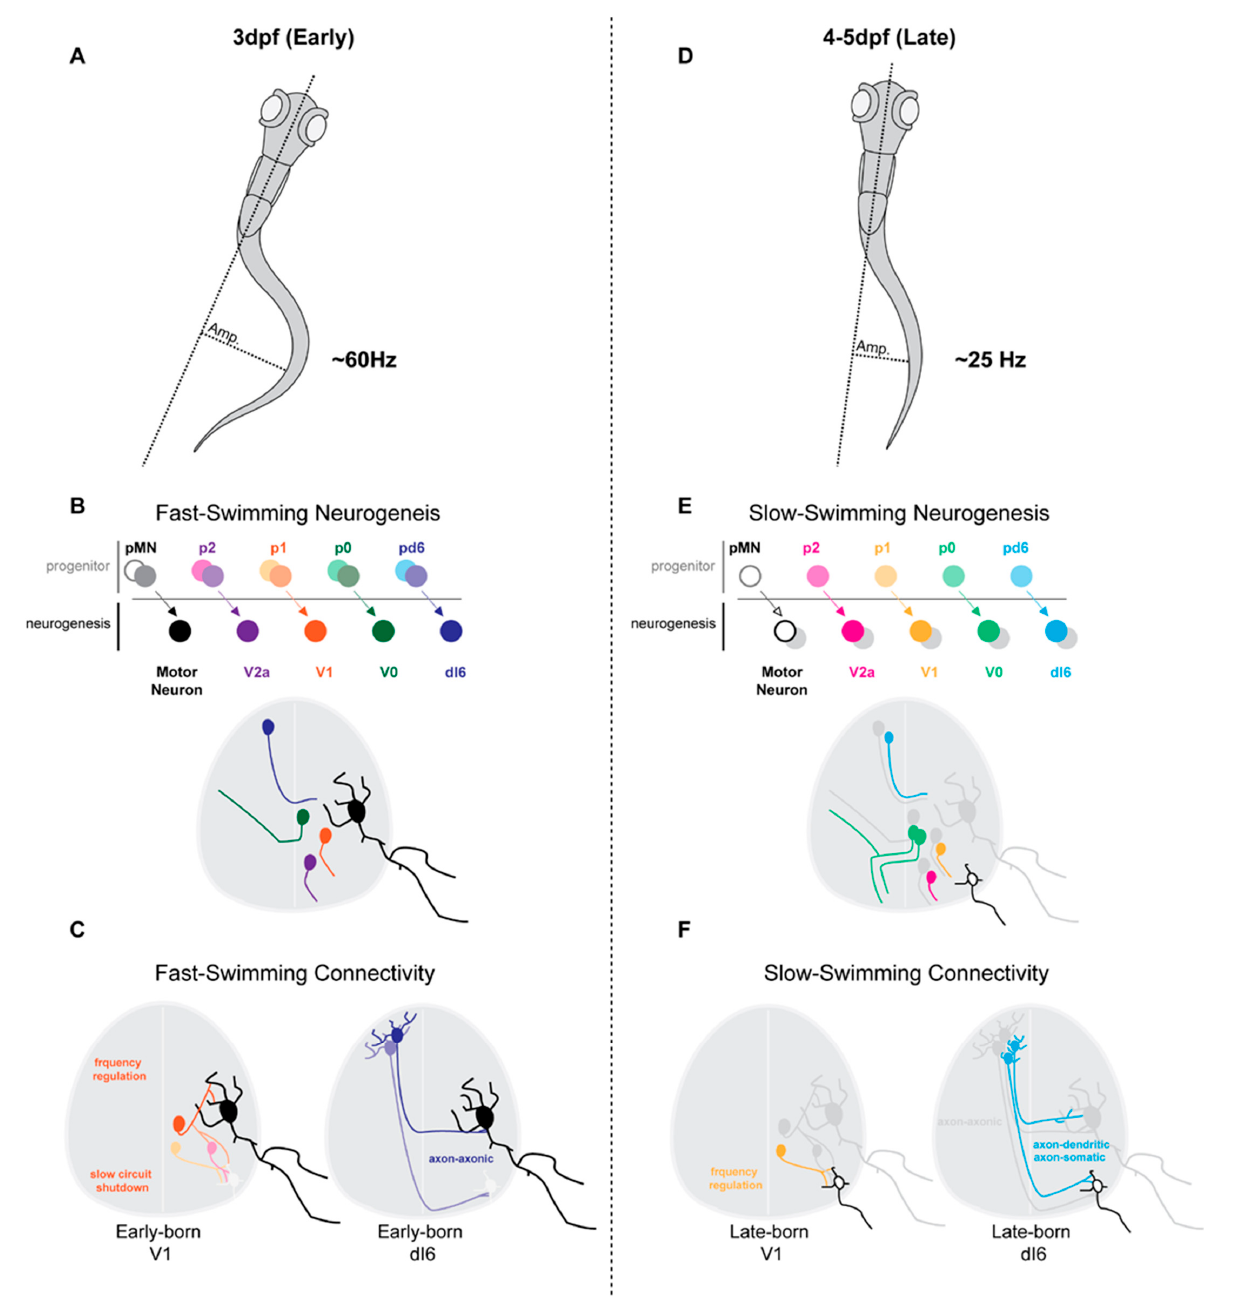
Figure 2. Sequential waves of neurogenesis separate zebrafish spinal cord neurons along neurogenesis time- and speed-matched axes. Large amplitude (Amp) and high frequency swimming emerge early, at 3 days post feralization (dpf), in the zebrafish larvae ( A ). Small amplitude (Amp) and low frequency swimming emerge later, at 4–5 days post feralization (dpf), in the zebrafish larvae ( B ) [48,49]. Early maturation of swimming behaviours is underscored by sequential waves of neurogenesis ( C ), early-born and fast swimming recruitment; ( D ), late-born and slow swimming recruitment; motor neurons (MNs), [49]; V0, [48,49,55]; V2a INs, [52]; V1 INs, [53]; dI6 INs, [62]. Neurogenesis time- and speed-matched spinal IN subclasses display distinct circuit connectivities. Early-born V1 INs regulate MN burst termination of primary MNs during fast-swimming as well as slow-swimming circuit shutdown of slow speed V2a INs and secondary MNs [54]. Early-born dI6 INs form axon-axonic synaptic connectivities with MNs and are recruited during fast-swimming ( E ). Late-born V1 INs regulate MN burst termination of secondary MNs during slow-swimming. Late-born dI6 INs form axon-somatic and axon-dendritic synaptic connectivities with MNs and are recruited during slow-swimming ( F ) [54].